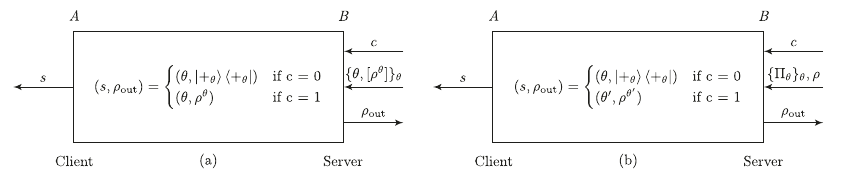
Fig. 5 RSP ideal resources for blindness and measured-based RSP for blindness. The fi ltered control bit c = 0/1 denotes the honest/ dishonest behavior of the server. The fi ltered functionalities with the input fð θ ; ½ ρ θ (cid:5)Þg θ of resource ( a ), and { Π θ }, ρ of resource ( b ) are accessible only to the dishonest server with c =